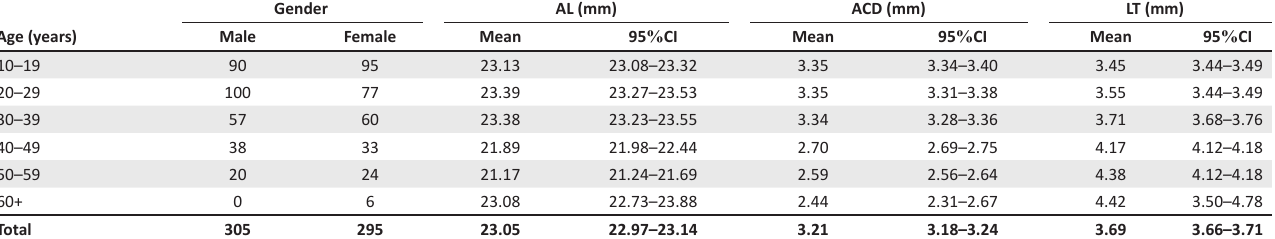
TABLE 1: Means and 95 % confidence intervals of axial length, anterior chamber depth and lens thicknesses. Age and gender are also included in the table distributions. Age (years)